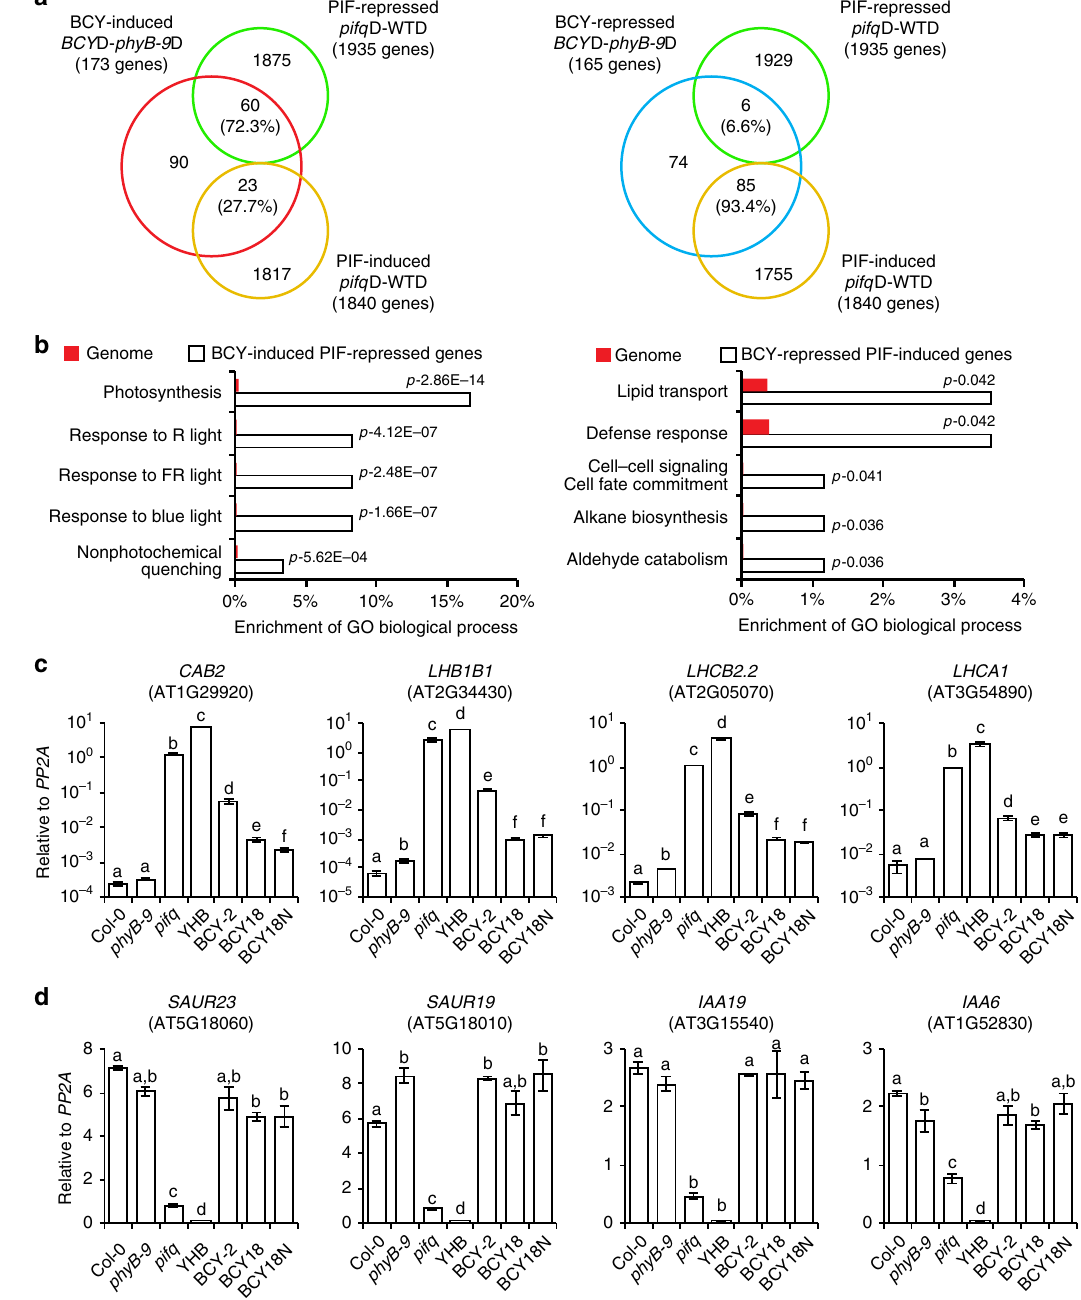
Fig. 5 The C-terminal module of PHYB regulates a subset of PIF-dependent genes. a Venn diagrams showing that 72.3% of BCY-induced and PIF- dependent genes are PIF-repressed and 93.4% of BCY-repressed and PIF-dependent genes are PIF-induced. b GO term enrichment analysis showing the top fi ve enriched biological processes with the lowest p-value for the BCY-induced, PIF-repressed genes (left panel) and the BCY-repressed, PIF-induced genes (right panel). c qRT-PCR results showing the expression levels of four representative BCY-induced, PIF-repressed photosynthetic genes in 4-day-old Col-0, phyB-9 , pifq , YHB , BCY-2 , BCY18 , and BCY18N seedlings grown in the dark. d qRT-PCR results showing the expression levels of four representative PIF-induced growth-relevant genes in 4-day-old Col-0, phyB-9 , pifq , YHB , BCY-2 , BCY18 , and BCY18N seedlings grown in the dark, indicating that this